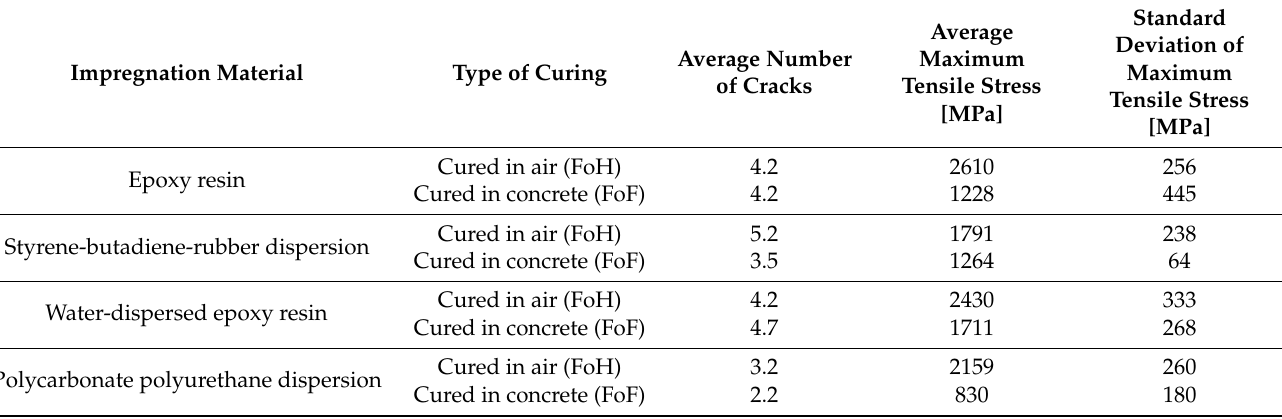
Table 5. Maximum tensile stresses at breaking point for TRC tensile test specimens reinforced with impregnated rovings and the uncoated control.